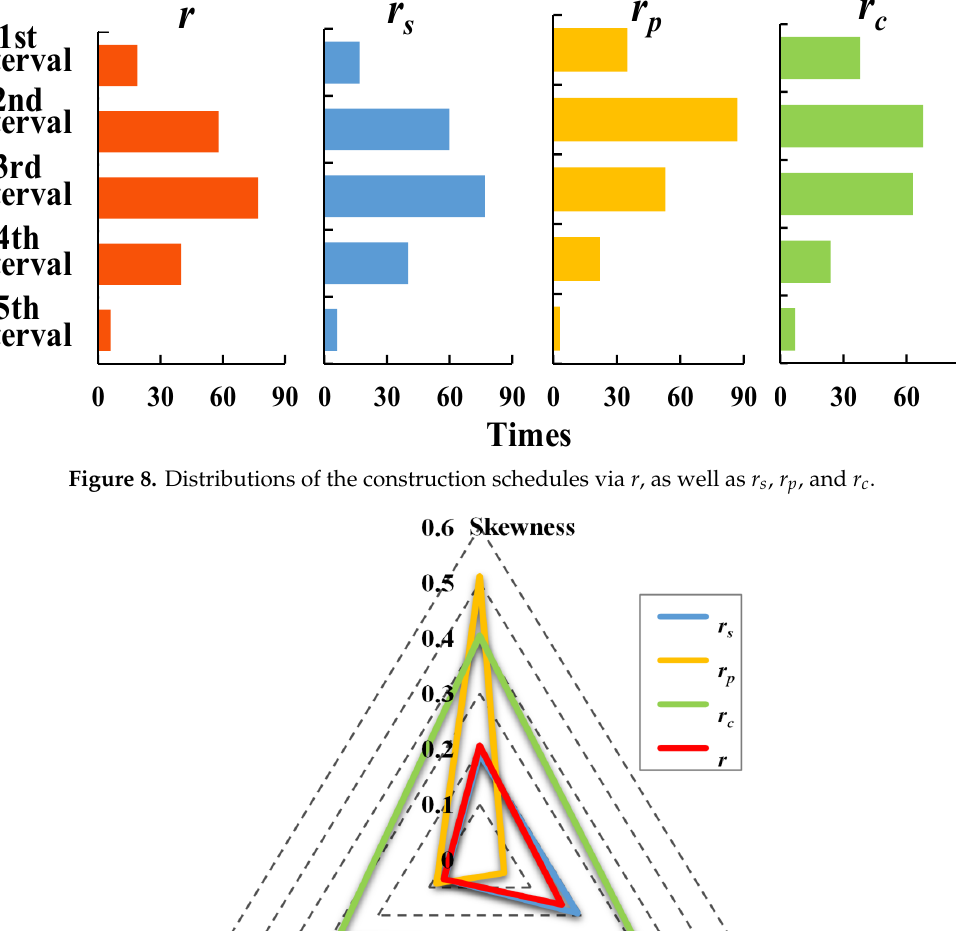
Figure 10. The optimized schedules with the objectives of T ‐ r , T ‐ r s , T ‐ r p , and T ‐ r c . r c / % 7078 0.3